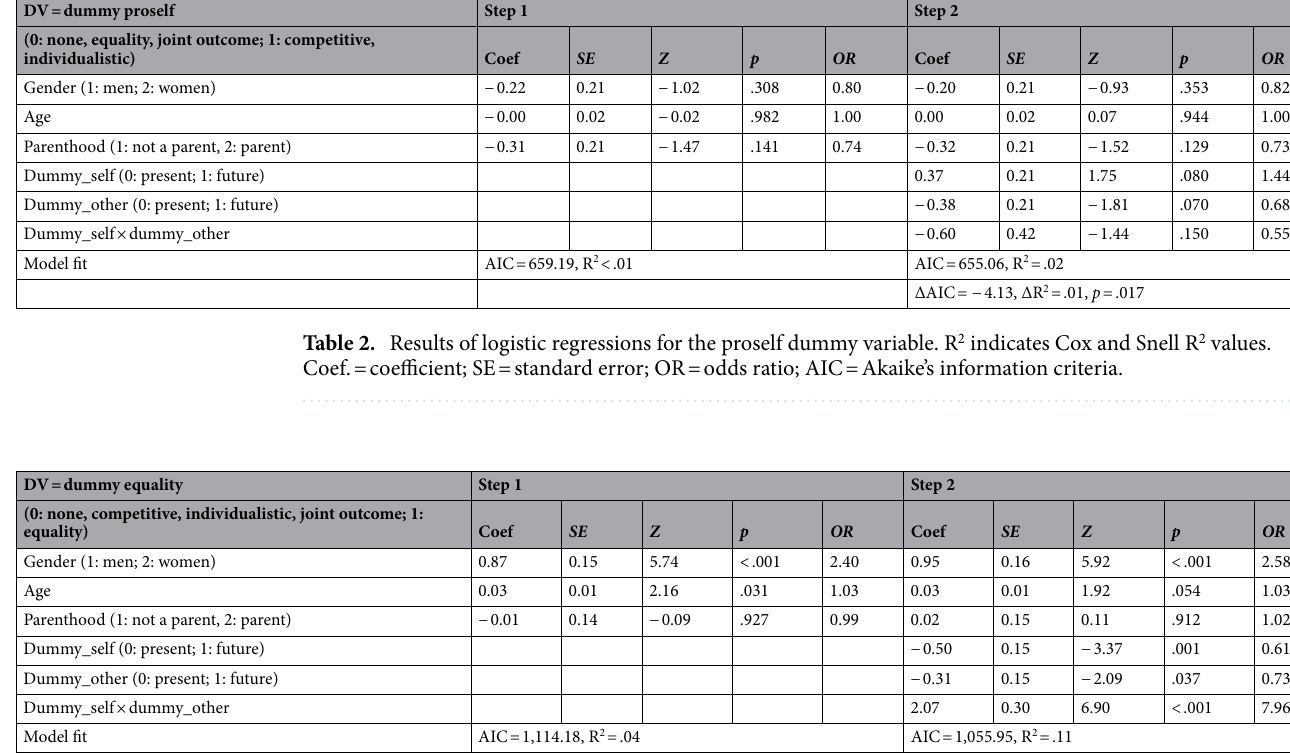
Table S6; ΔAIC = 0.77, ΔR 2 < 0.01, p = 0.268). In the sub-sample featuring the present-self condition (dummy